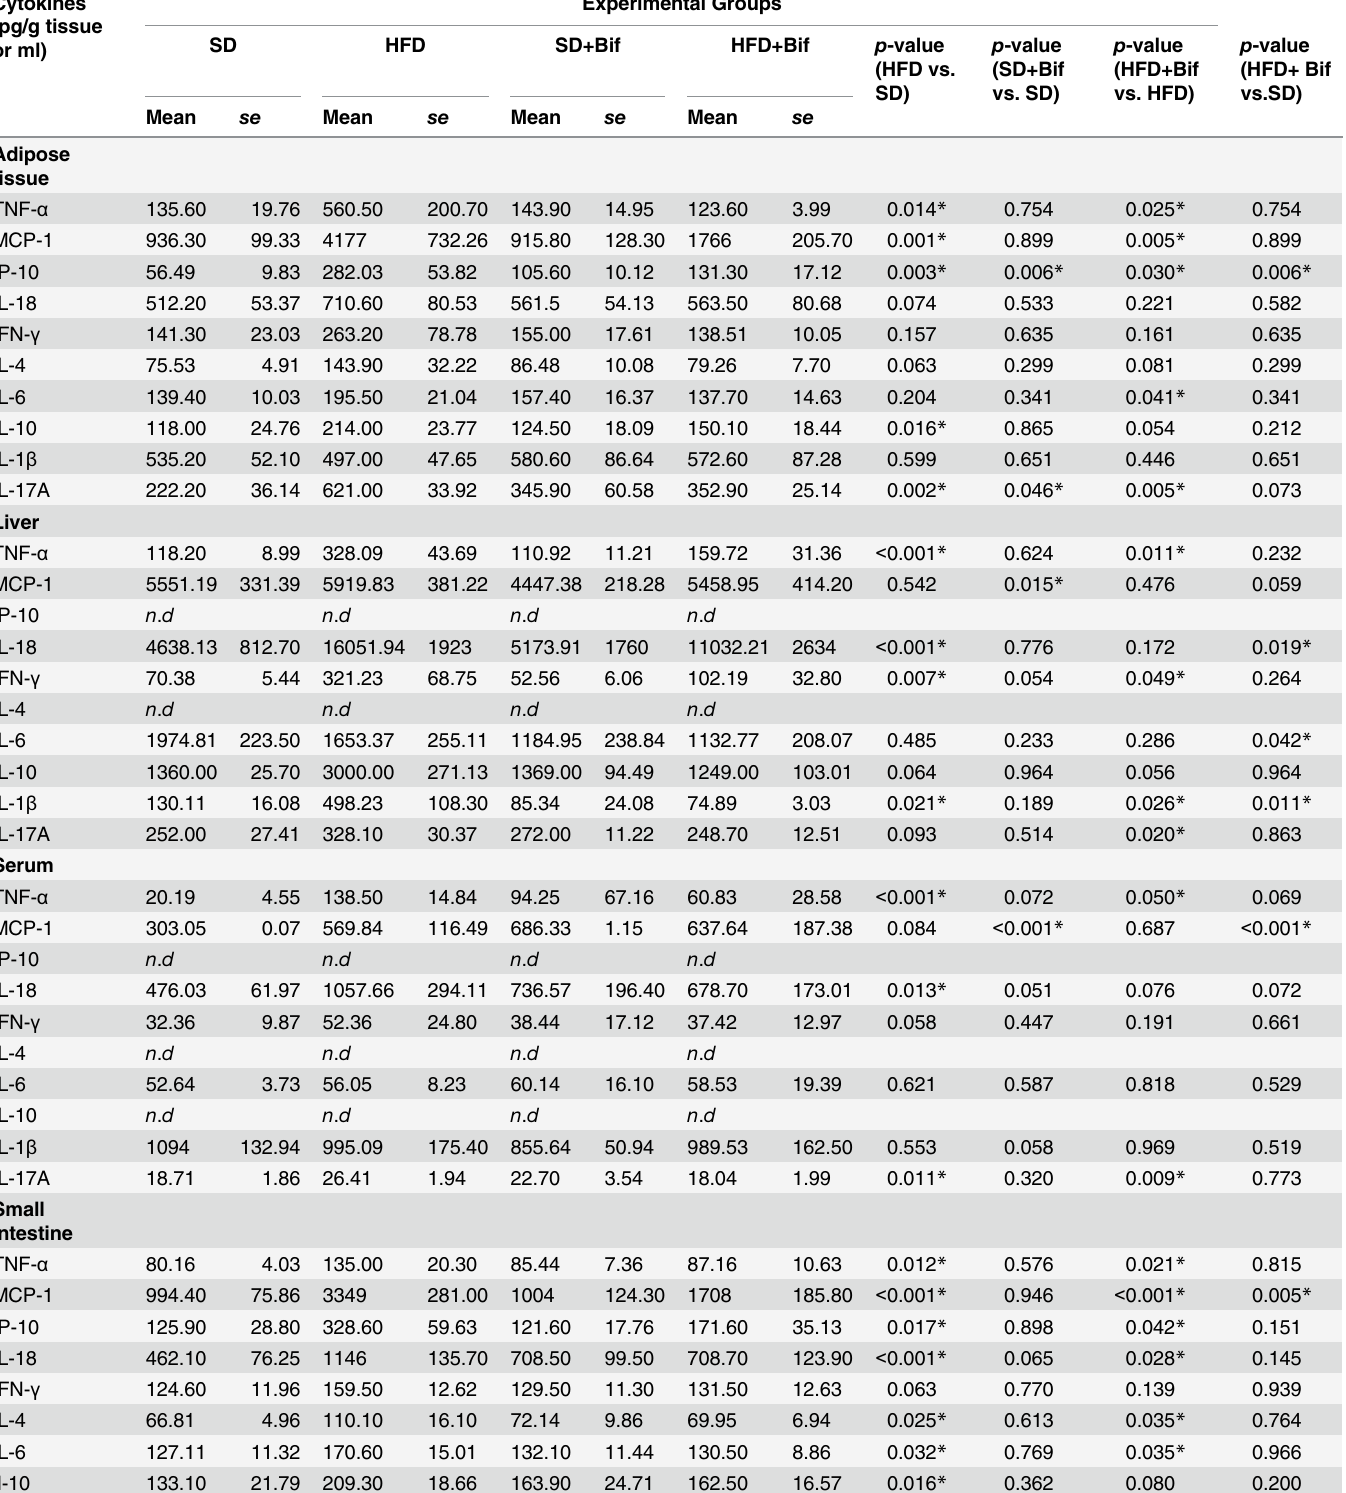
Table 2. Cytokine and chemokine concentrations in tissues and serum from different mouse groups after 14 weeks dietary intervention. Cytokines (pg/g tissue or